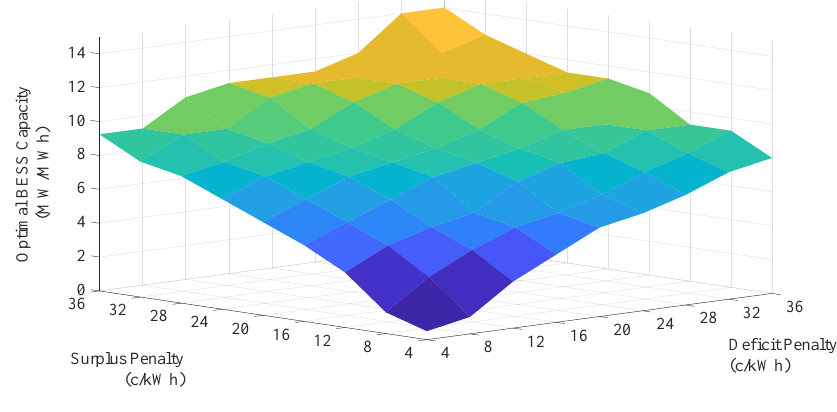
Figure 17. Optimal BESS size (MW/MWh). Table 5. Optimal BESS size (MW/MWh); penalties are in